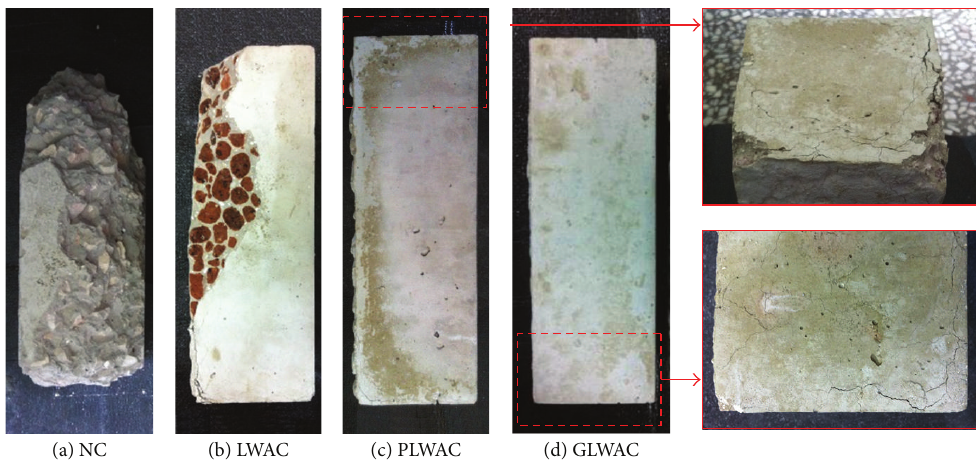
Figure 2: Spalling of the concrete specimens.